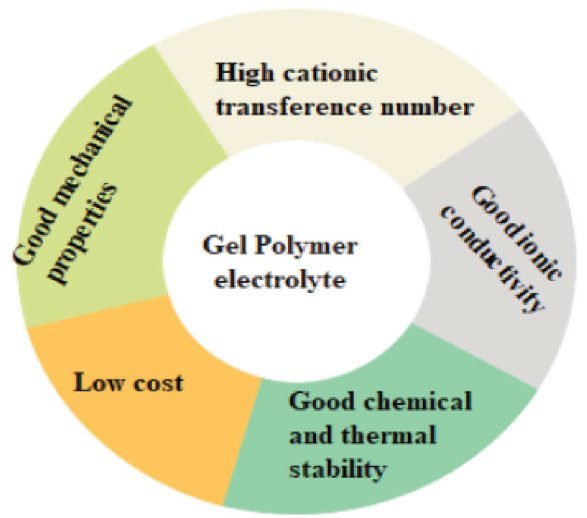
Fig. 4 Schematic representation of fundamental requirement of GPE for RZAB modified from reference [61]